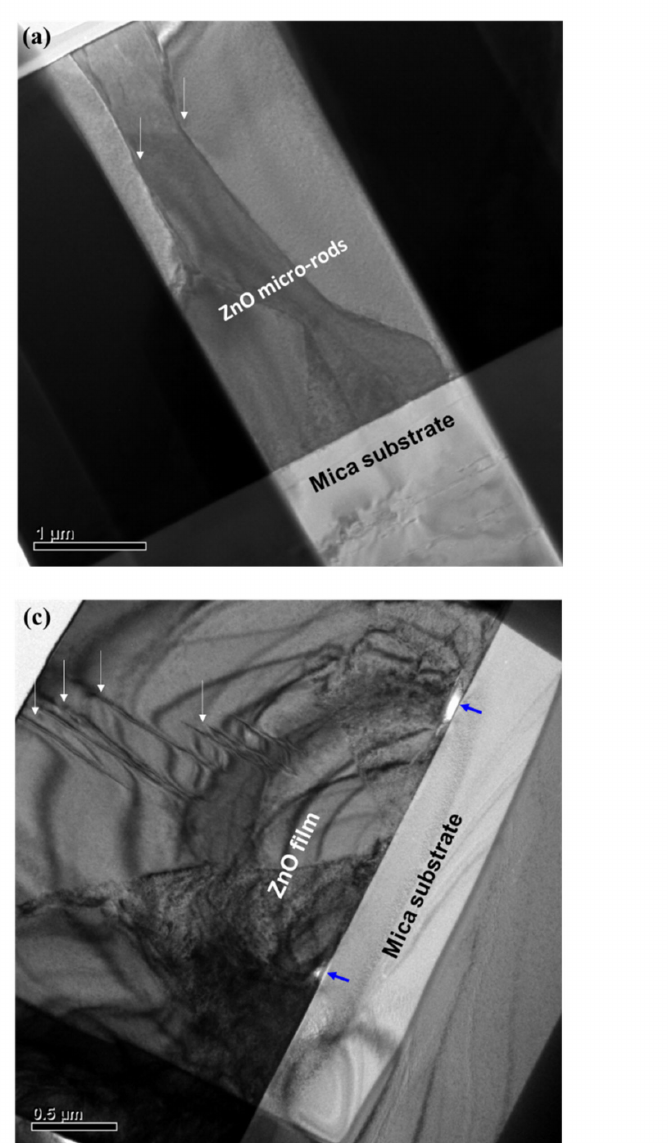
Figure 5. ( a ) Cross-sectional bright-field TEM images of ZnO micro-rods and film hydrothermally grown on mica substrates from solutions containing ( a ) 0.25 mM and ( c ) 0.5 mM sodium citrate. ( b , d ) Corresponding SAED patterns recorded at the interfacial